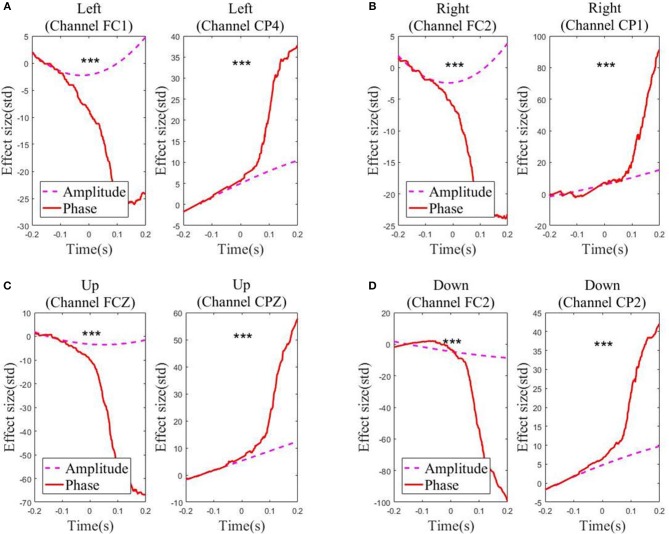
Effect sizes for the low-delta EEG amplitude feature and phase feature quantified in standard deviation units in the representative channels for the grand average across subjects and sessions along the four directions: (A) Left. (B) Right. (C) Up. (D) Down. Those channels, which exhibit statistical significant differences (signed rank test p << 0.01) in effect size for the amplitude feature and the phase feature during the movement sub-interval (0–0.2 s), are marked by ***.